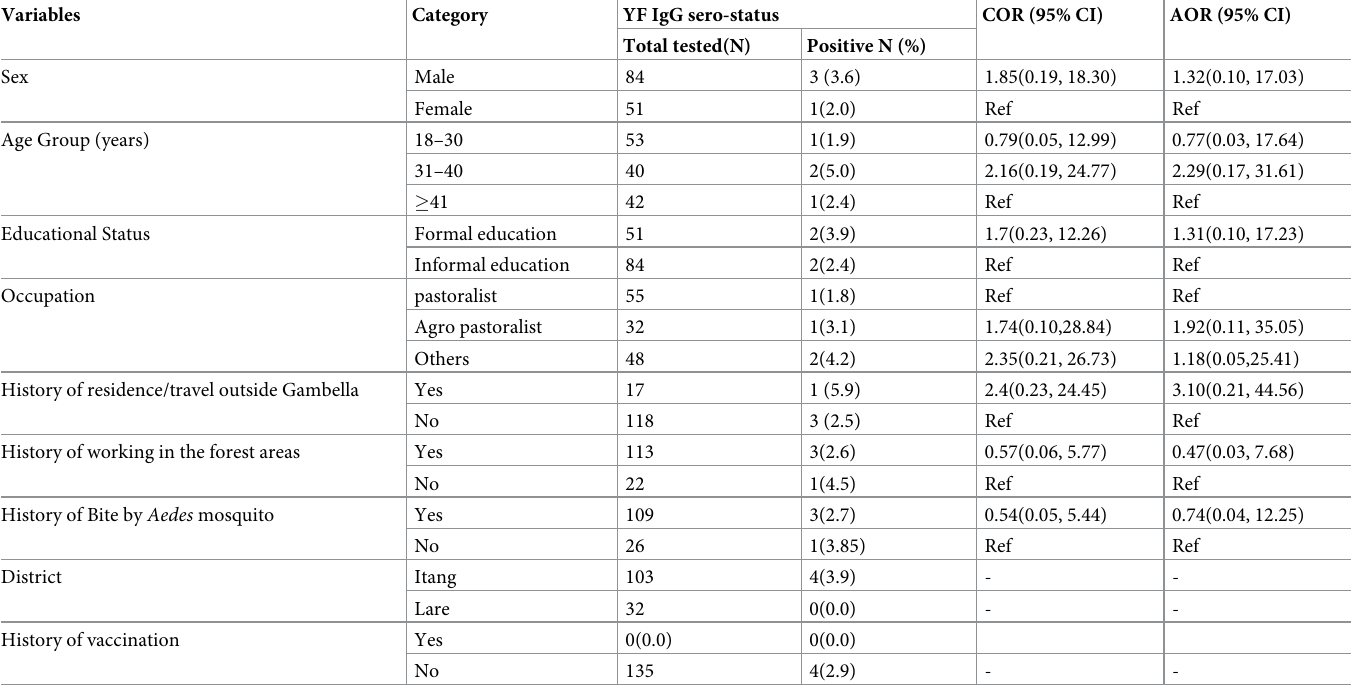
Table 2. Sero-positivity for IgG antibody to YFV infection and associated factors (N =